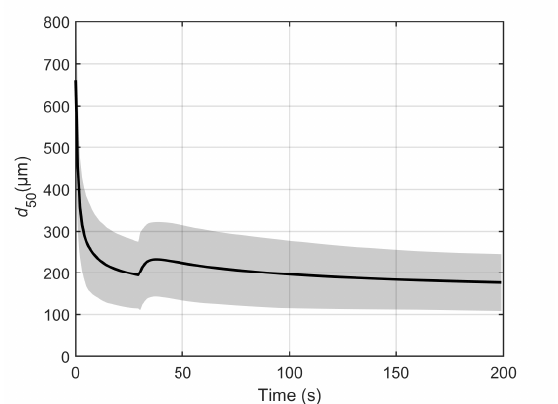
Figure 7. Model prediction (black solid) with 95% confidence range (shaded) using first-order polynomial chaos. Twelve samples were drawn using the Latin hypercube